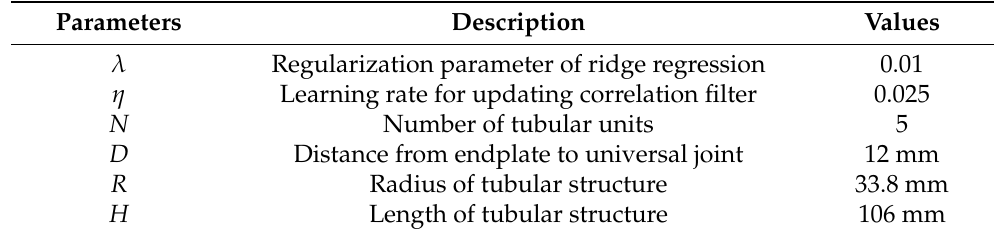
Figure 7. The prototype entity. Table 1. Some parameters selected in the experiment.